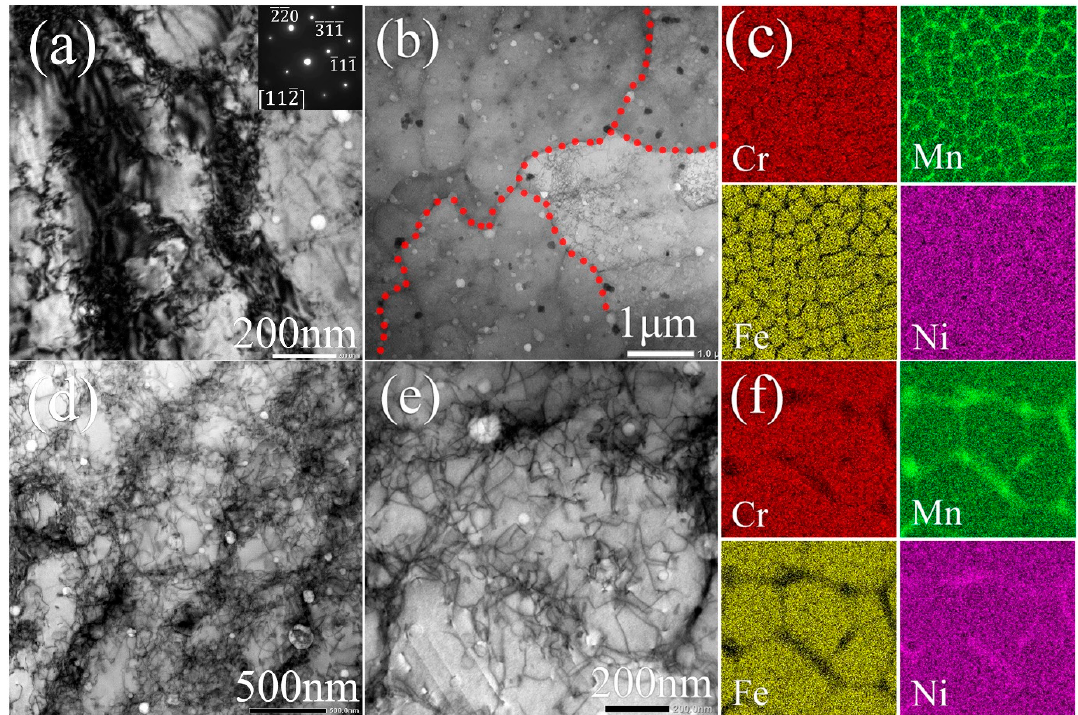
Figure 5. TEM observation on the XY-plane of SLM-2 CrFeNiMn alloy. ( a ) BF TEM image of equiaxed cells with the corresponding selected area electron diffraction (SAED) pattern. BF STEM image of ( b ) equiaxed cells with ( c ) corresponding quantitative EDS maps; ( d ) detailed equiaxed cells and dislocation networks and ( e ) magnified equiaxed cells with ( f ) corresponding quantitative EDS maps of elemental distribution in the sub-cell structure.